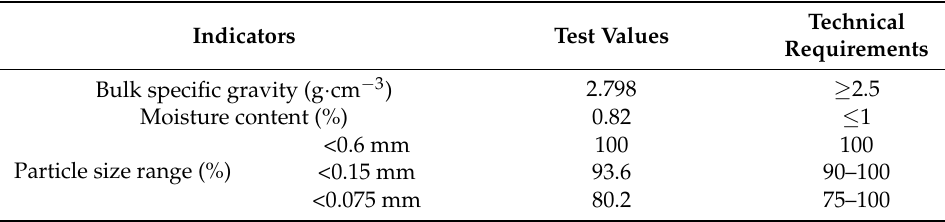
Table 5. Basic technical indicators of mineral powder.